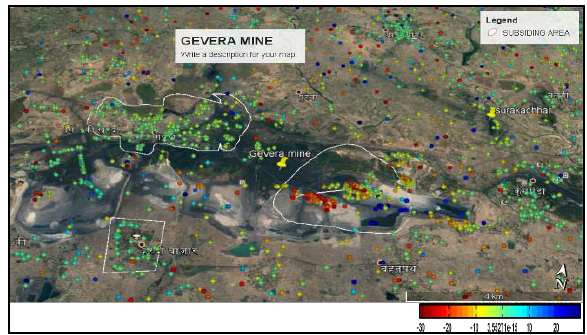
Figure6 Zoomed view of in and around opencast mine Gevera